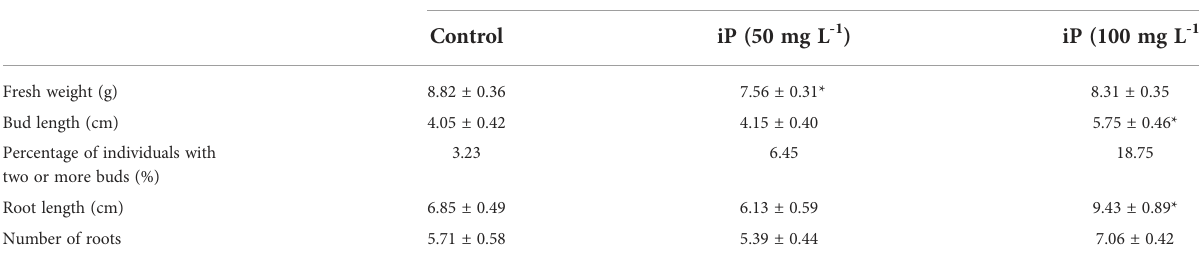
TABLE 1 Effect of iP application on the growth traits of A. muelleri .